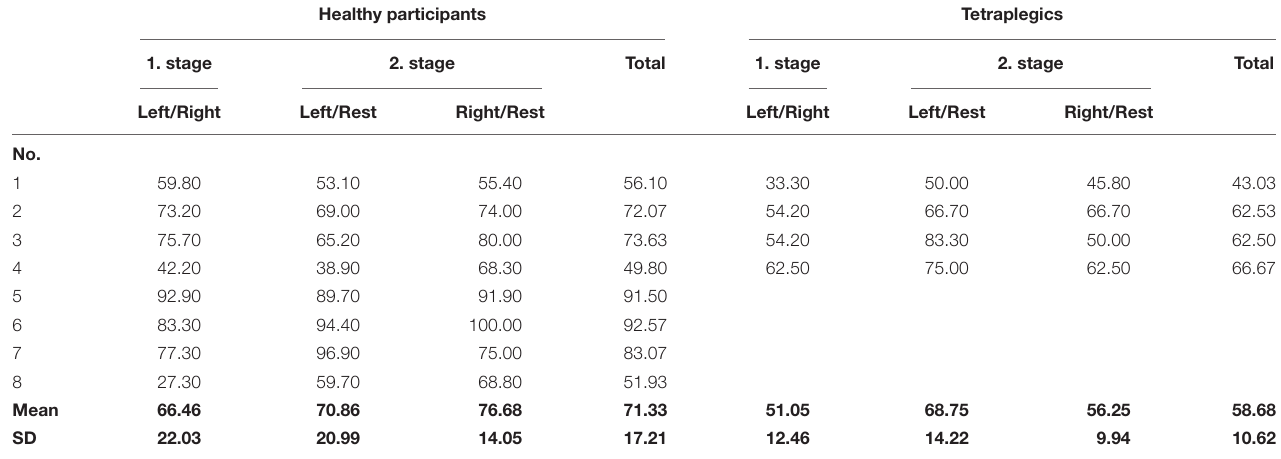
TABLE 3 | Accuracy of standard electroencephalography (EEG)-based hierarchical classifier. Healthy participants